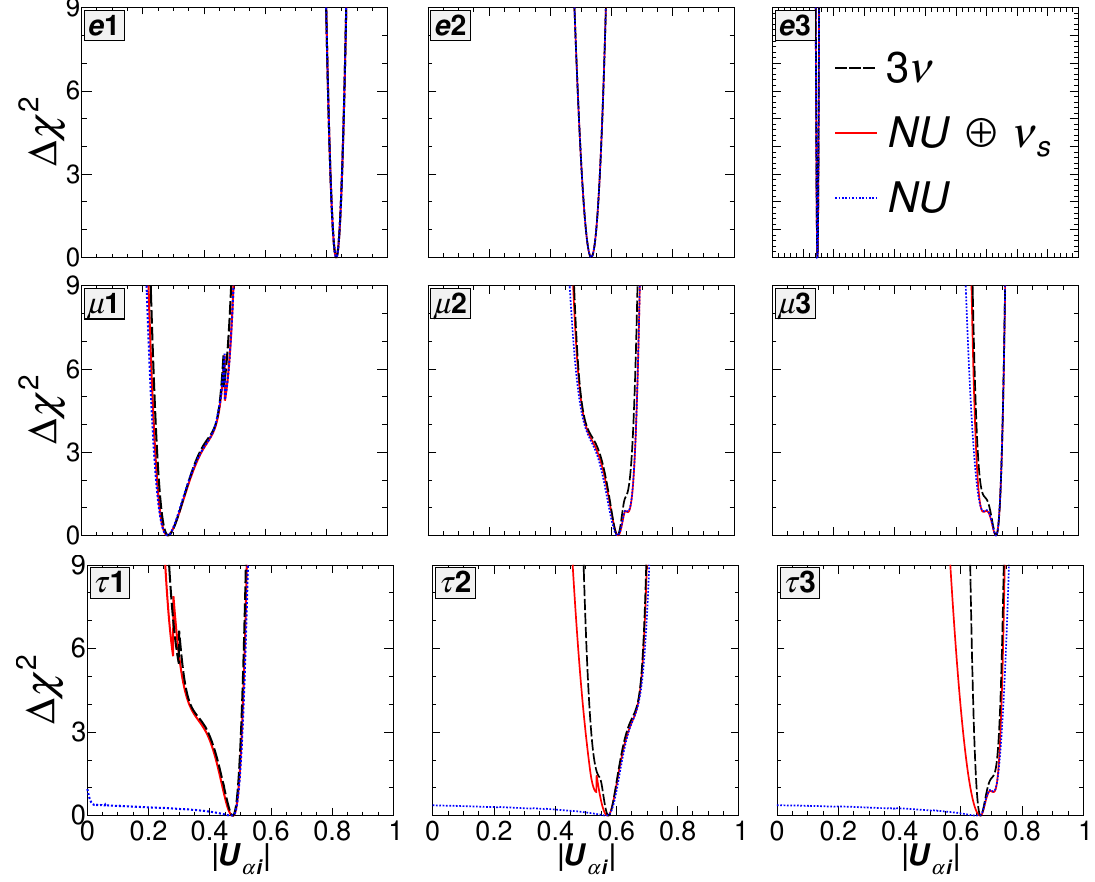
Figure 1 . The constraints on the moduli of the mixing matrix elements with (black dashed) and without (red solid) unitarity. The x-axes are the moduli of matrix elements, ranging from 0 to 1. The y-axes are the ∆ χ 2 , ranging from 0 to 9. A fit setting χ 2 sterile neutrinos, is also shown (blue